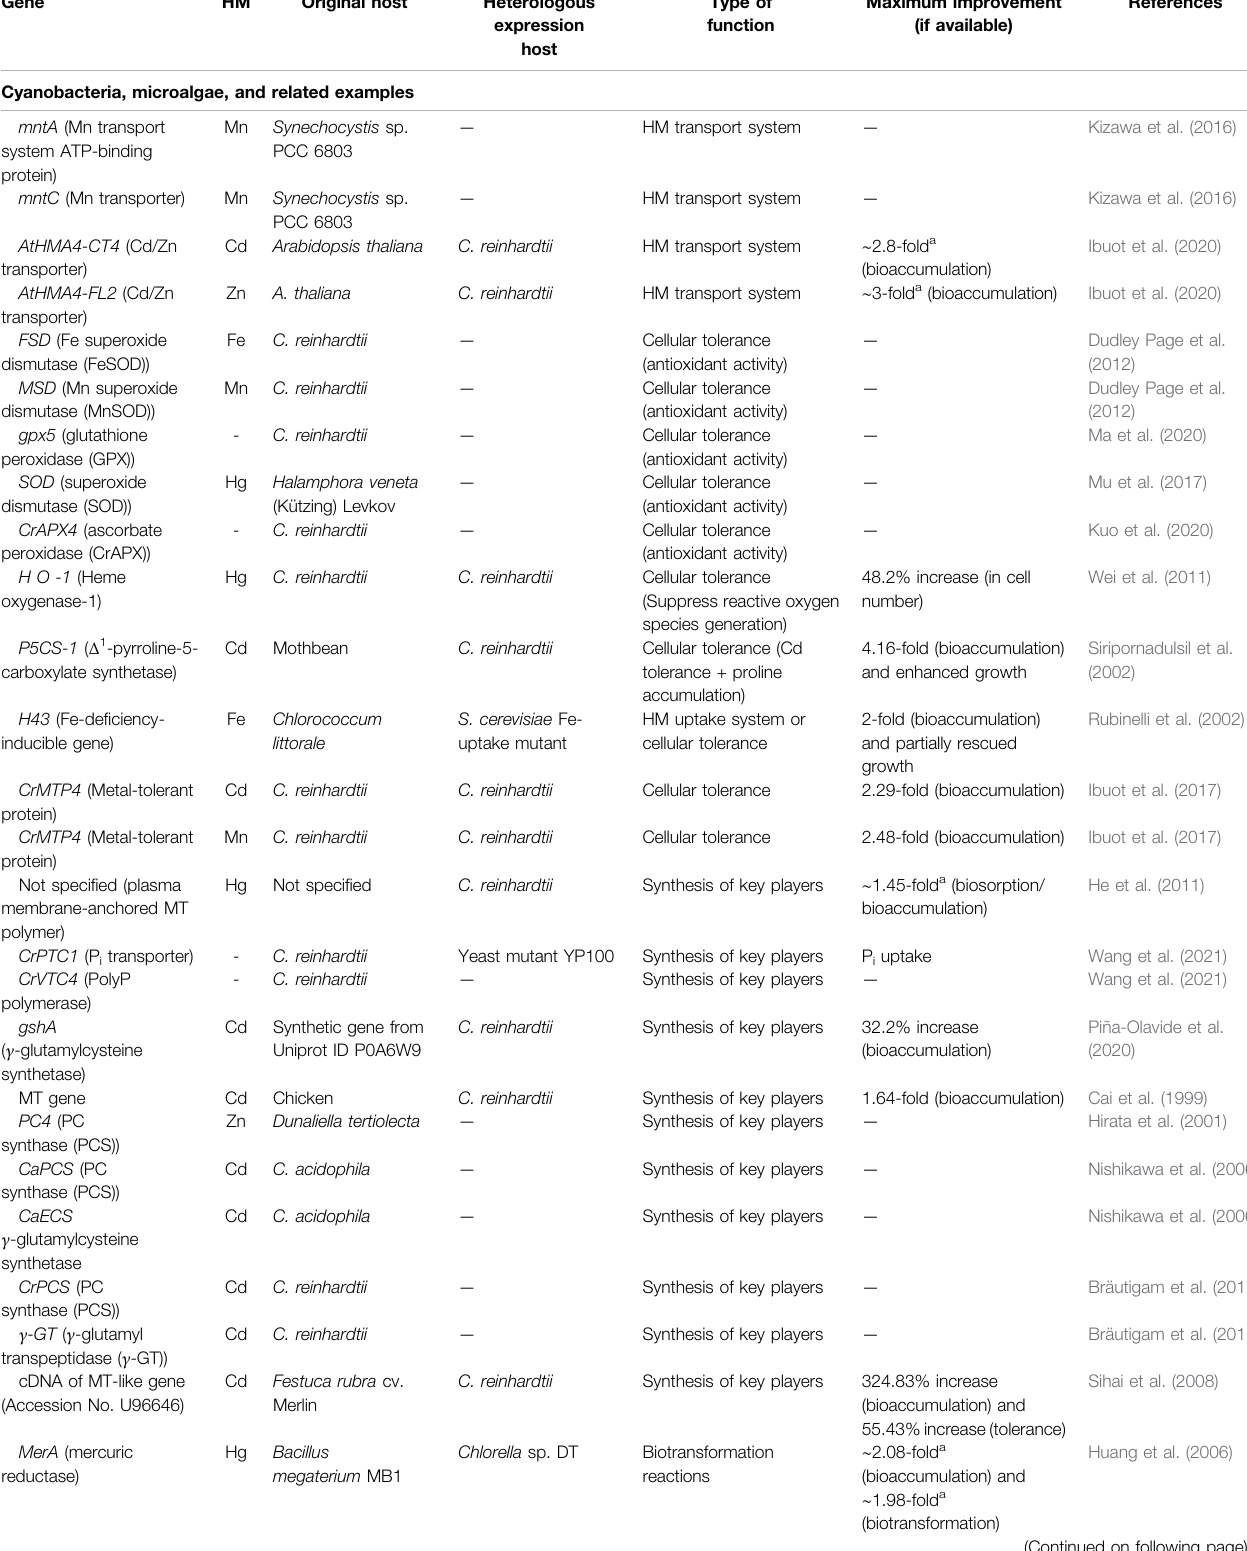
TABLE 1 | List of genes involved or reported on heavy metal (HM) bio-removal.